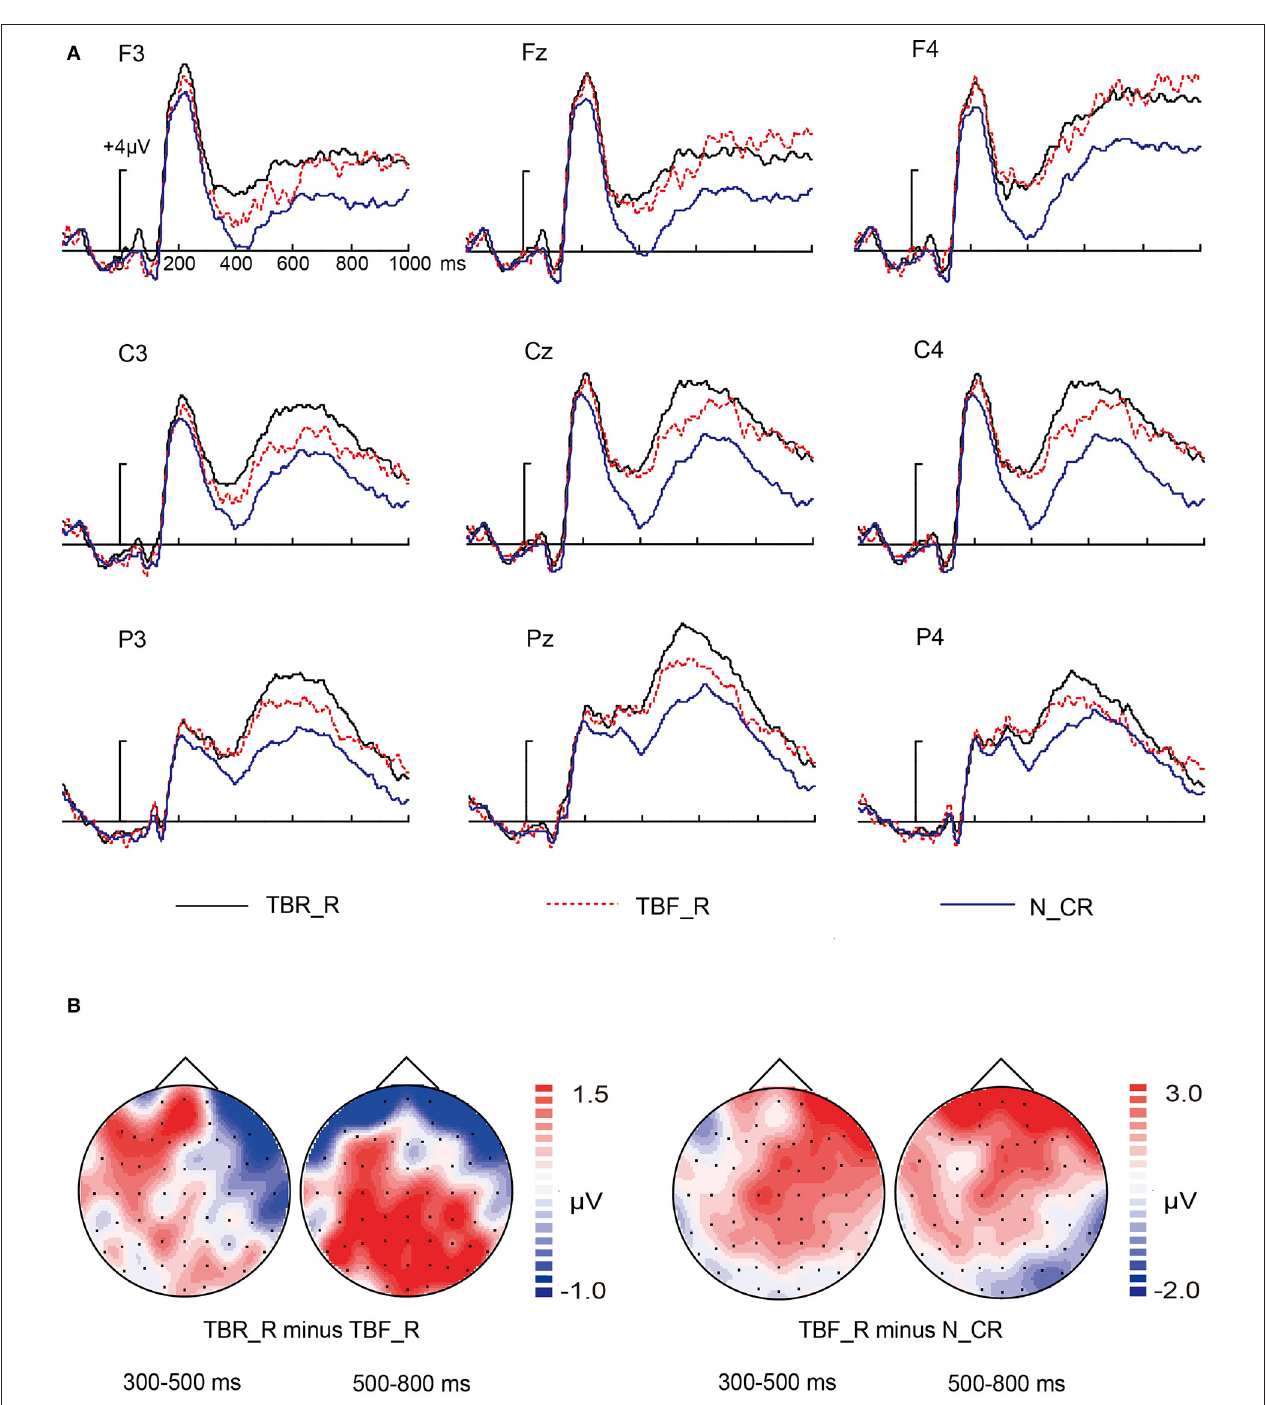
FIGURE 4 | ERP for TBF_R, TBR_R, and N_CR condition. (A) Waveforms are shown from F3, Fz, F4, C3, Cz, C4, P3, Pz, and P4 electrodes. (B) The left two topographical plots depict ERP differences between TBF_R condition and TBR_R condition at 300–500 ms interval and 500–800 ms interval; the right two topographical plots depict ERP differences between TBF_R condition and N_CR condition at 300–500 ms interval and 500–800 ms interval.